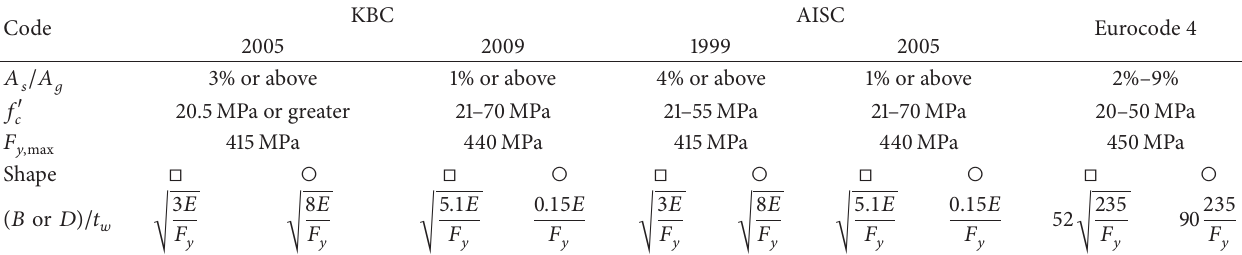
Table 2: Specifications regarding CFT in national design codes.